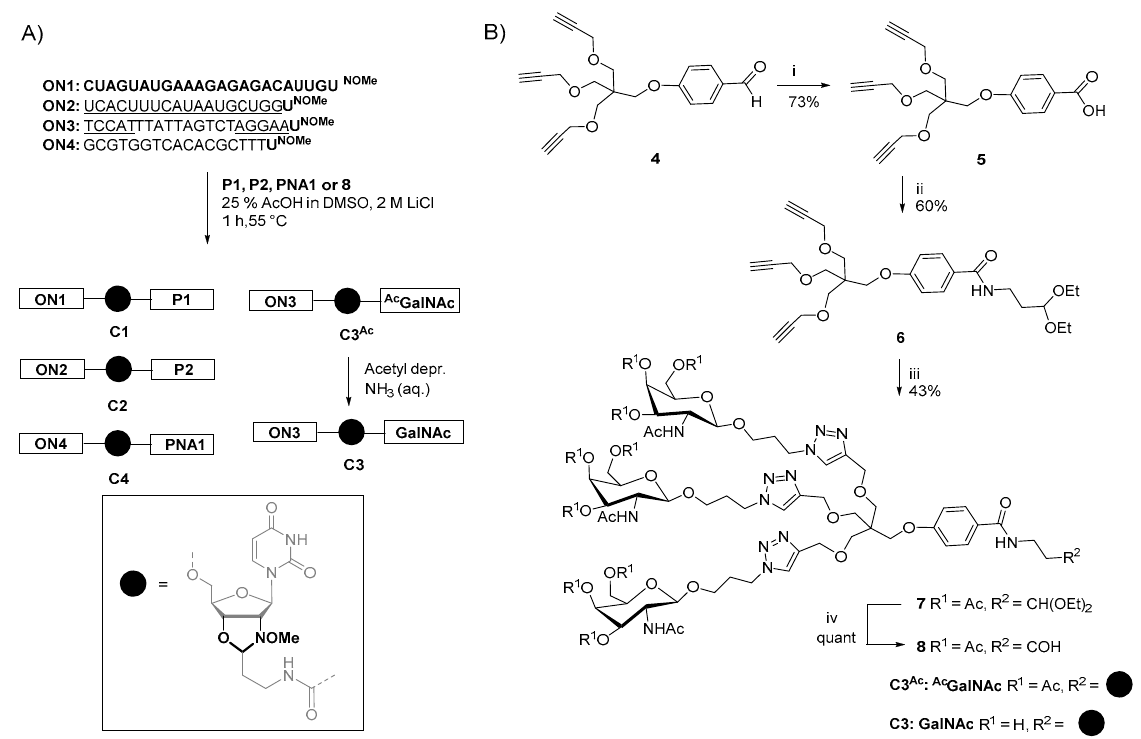
Table 3. Data of the N -(methoxy)oxazolidine ligation to obtain conjugates C1 - C4 . Conjugate Aldehyde